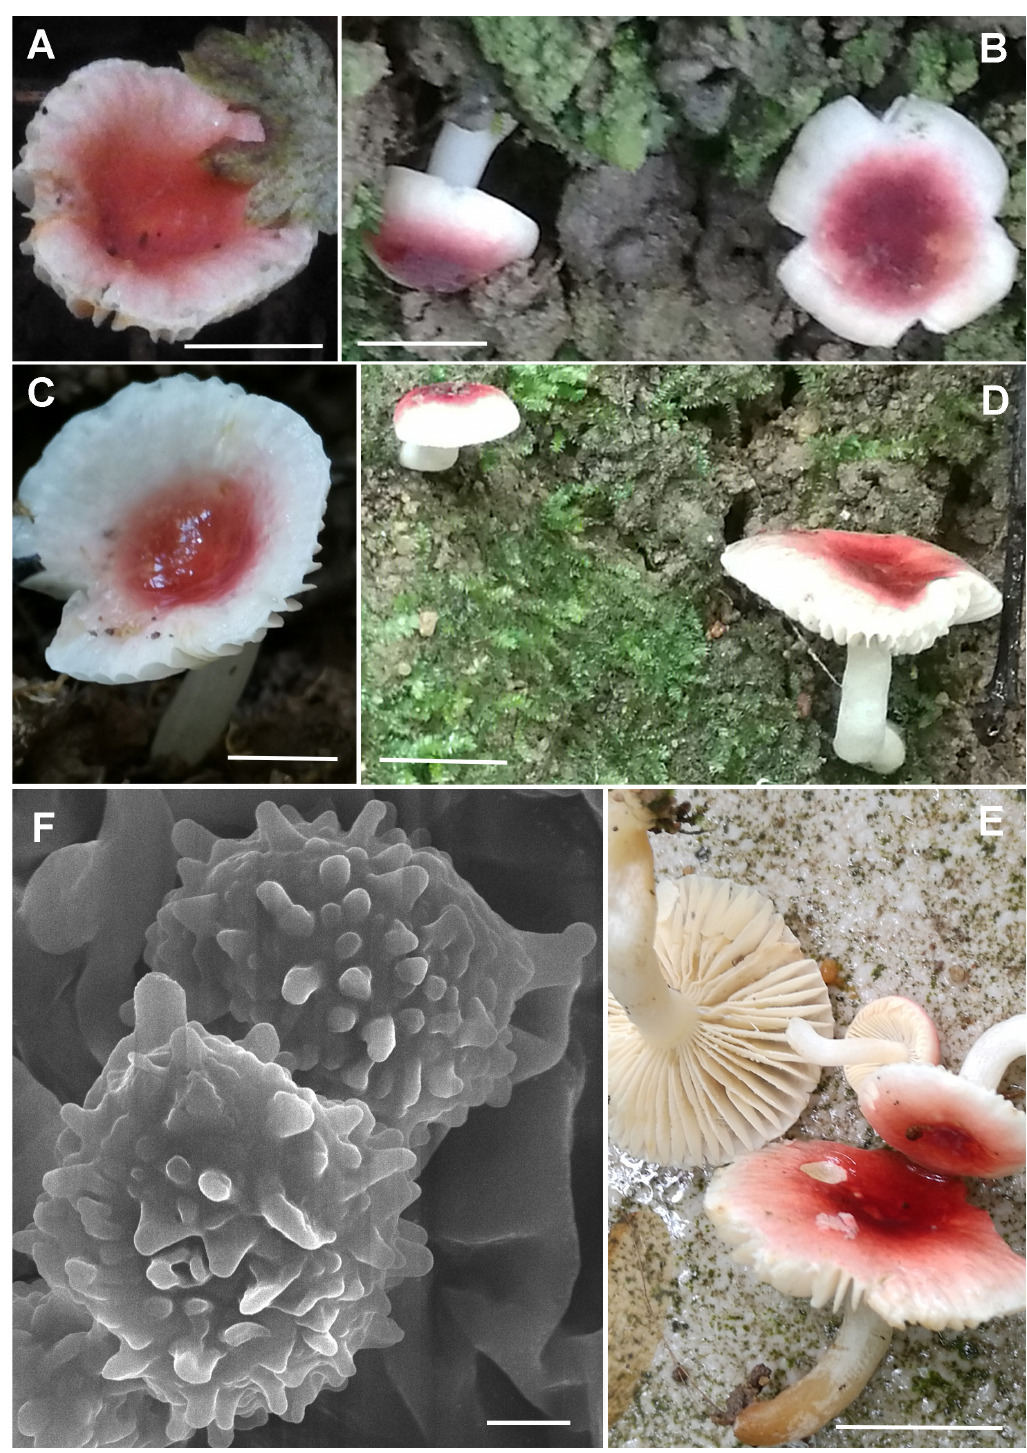
Fig. 5. Russula minor Y.Song sp. nov. A , E–F . Holotype, GDGM79686. B . GDGM79689. C . GDGM79687. D . GDGM79688. A–E . Fruiting bodies. F . Basidiospores under scanning electron microscope. Scale bars: A–E = 1 cm; F = 1